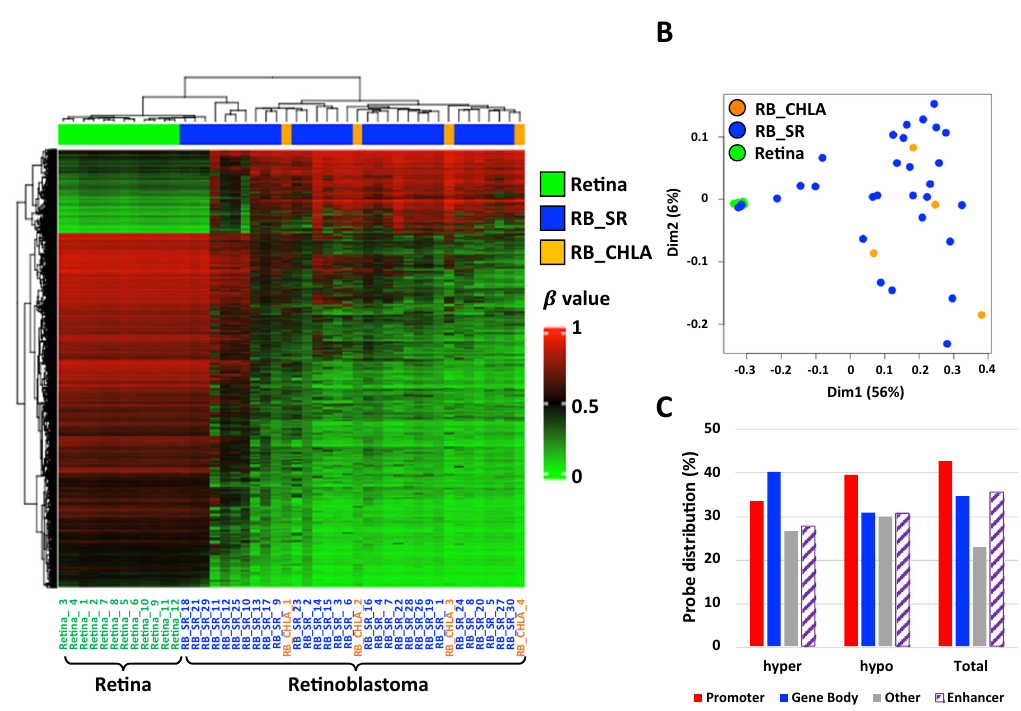
Fig. 1 | DNA methylation signatures in retinoblastoma (RB). A Unsupervised hierarchical clustering of the differentially methylated probes between RB and retina samples. The top annotation indicates sample type. Green and blue bars indicatetheretina(green, n =12)andRBsamples(RB_SR, n =30),respectively,from dataset GSE57362. Orange bars highlight the four primary RB tumor samples